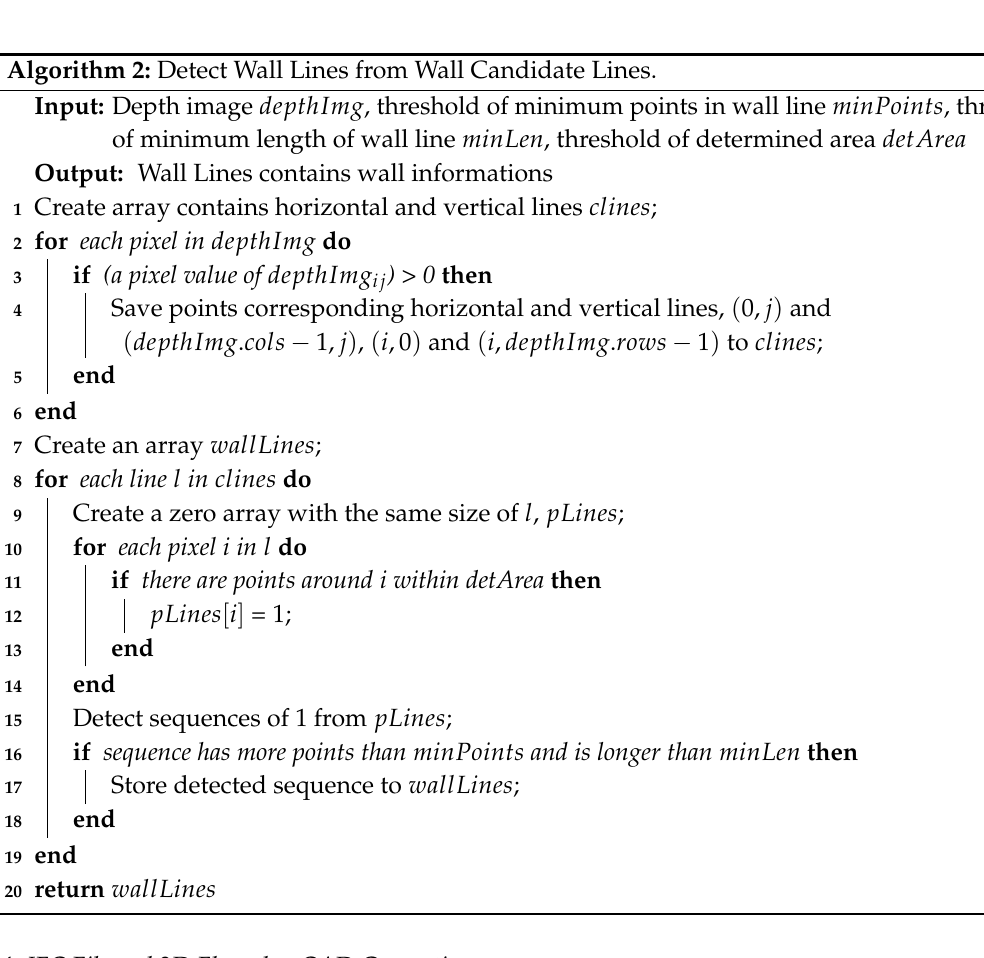
Algorithm 2: Detect Wall Lines from Wall Candidate